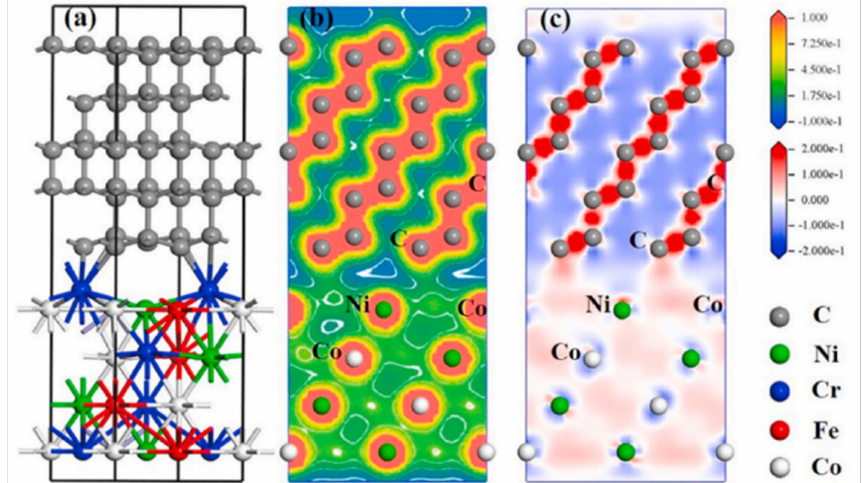
Figure 8. Optimized interface model of active brazed alloys Cr analogs/diamond-C ( a ), and its valence ( b ) and different charge density plots ( c ). Reprinted with permission from Ref. [47]. Copyright 2022,